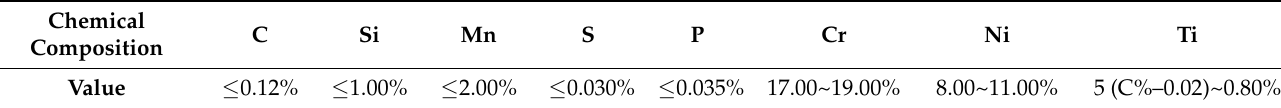
Table 1. Chemical compositions of 1Cr18Ni9Ti stainless steel.